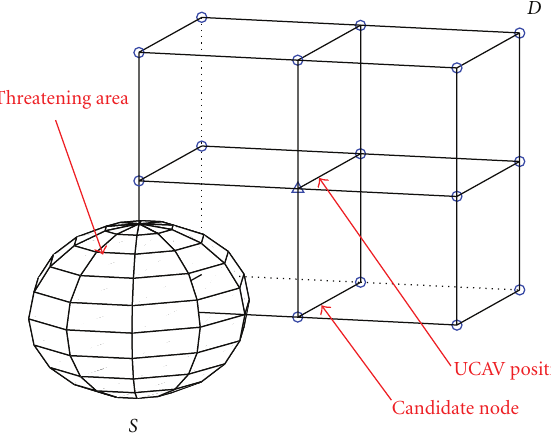
Figure 1: Typical UCAV battle field model in